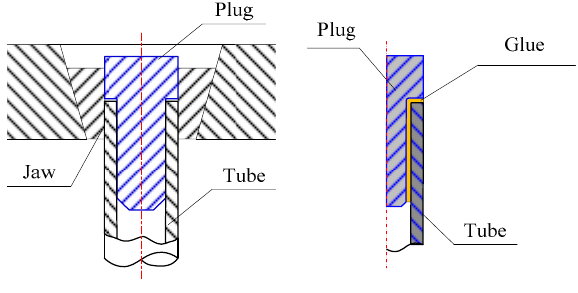
Figure 4. Clamping models for tube.